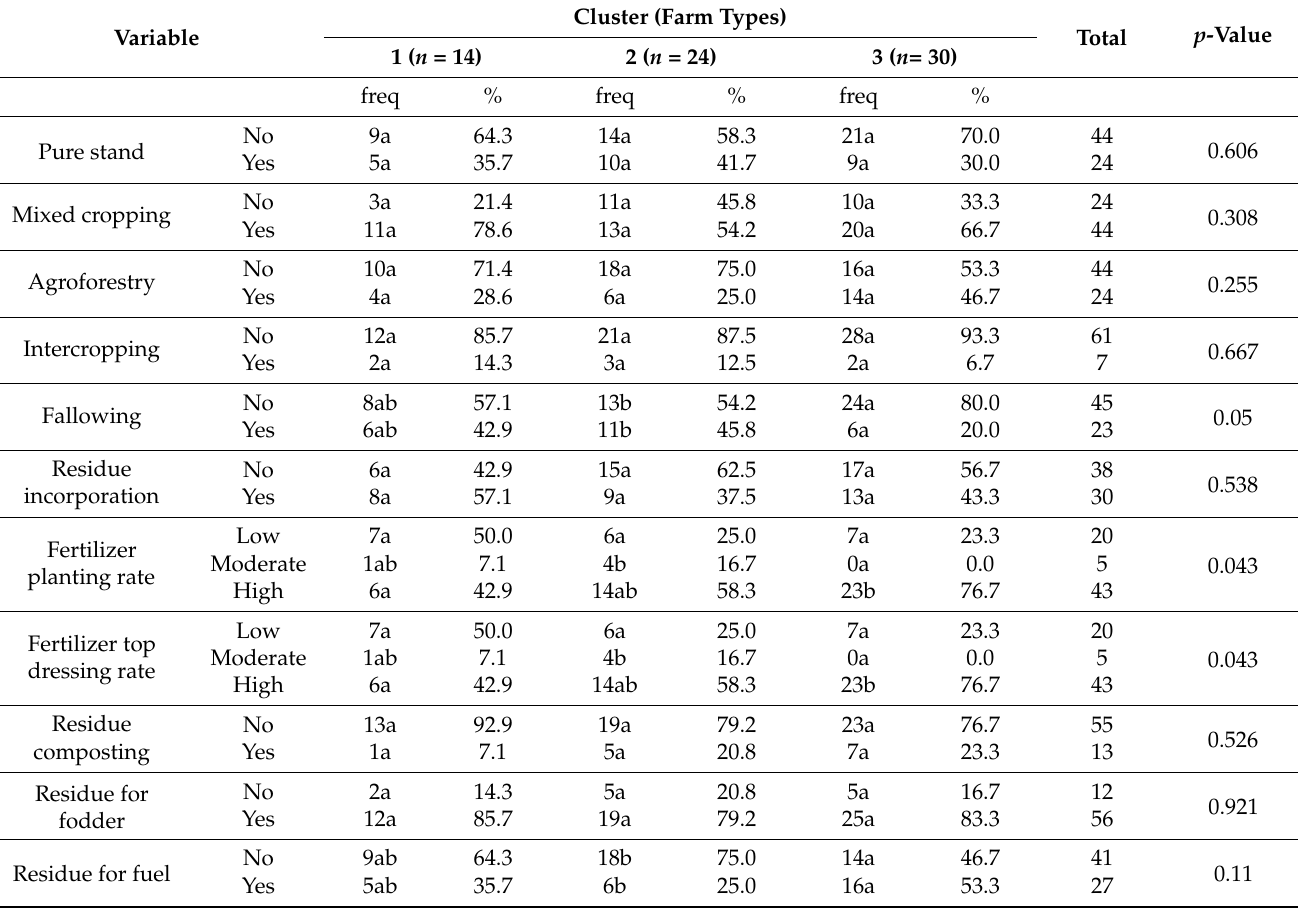
Table 10. Frequency distribution of soil fertility management characteristics across clusters (farm types) in Upper Eastern